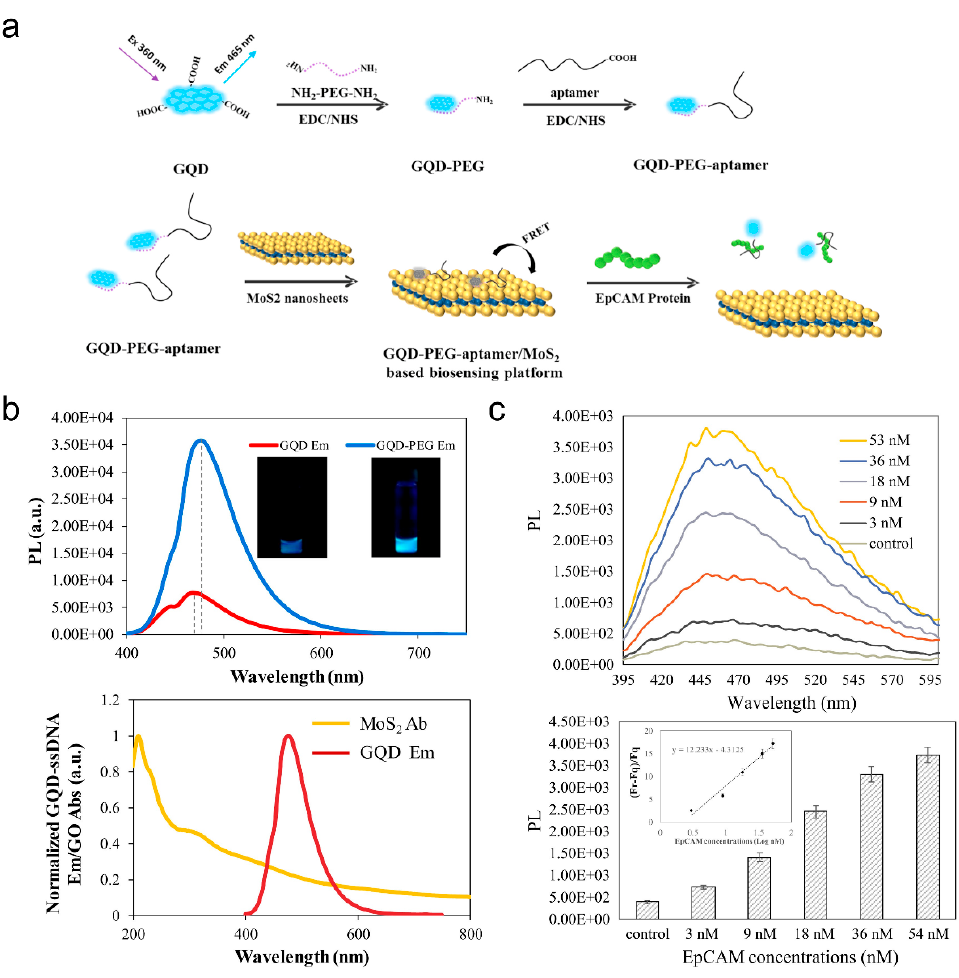
Figure 6. Harnessing aptamer-bearing graphene quantum dots (GQDs-PEG-aptamer) coupling onto MoS 2 nanosheets (GQDs-PEG-aptamer/MoS 2 ) as a FRET biosensor for epithelial cell adhesion molecule (EpCAM) detection. ( a ) Schematic illustration of the sensing mechanism of GQDs-PEG-aptamer/MoS 2 FRET nanosensor. ( b ) Photoluminescence (PL) intensity and emission spectra GQD with absorption spectra of MoS 2 . ( c ) Fluorescence recovery spectra and peak fluorescence signal of the FRET biosensor against various EpCAM concentrations. Figures are re-arranged and reprinted with permission from Ref. [88]. Copyright Elsevier Ltd. (2017).